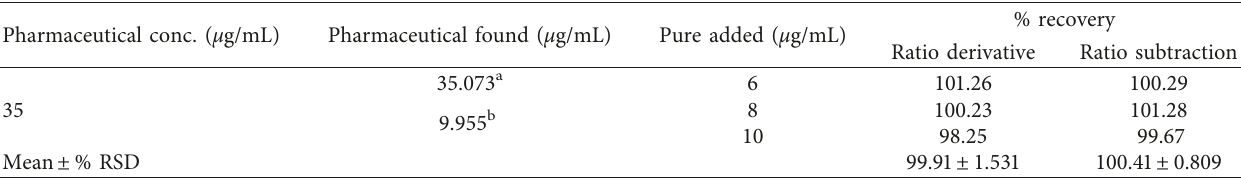
Table 3: Recovery study of aclidinium by adopting standard addition technique via the proposed ratio derivative and ratio subtraction methods.